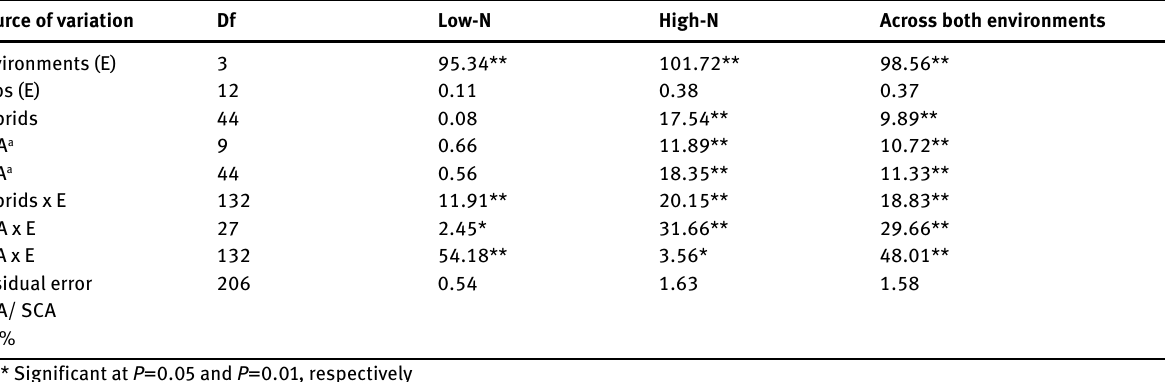
Table 2: Combined analysis of variance for grain yield in F1 hybrids and parents under low-N and high-N at Mokwa and Zaria in 2012 Source of variation Df Low-N